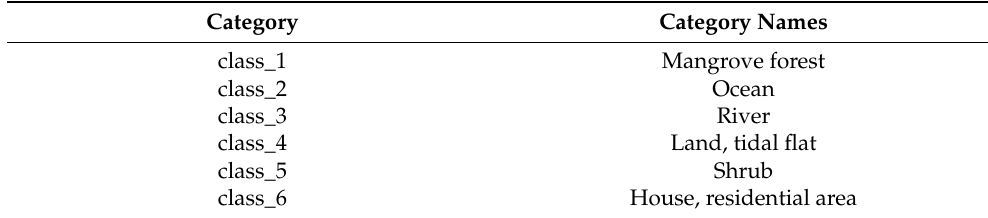
Table 1. Semantically Segmented Categories and Category Names.